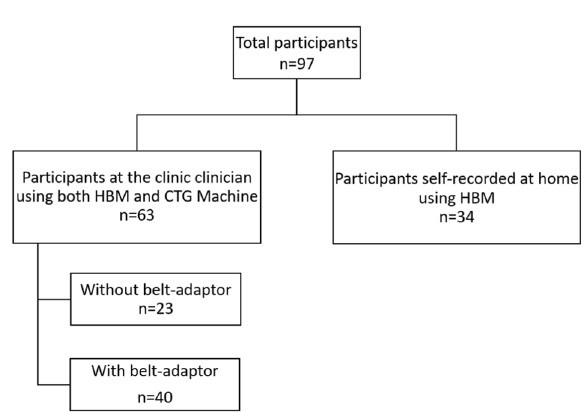
Fig. 1 Participants fl ow through the study. Heartbeat monitor (HBM), Cadiotocograph